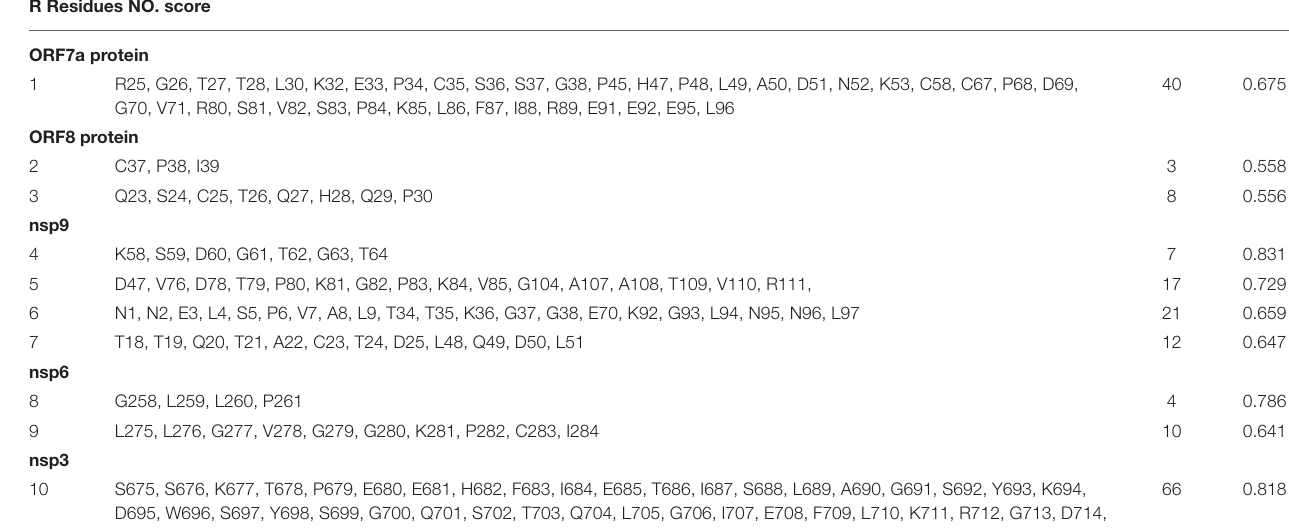
TABLE 5 | Predicted conformational B cell (BCL) epitopes of SARS-CoV-2 proteins. R Residues NO.